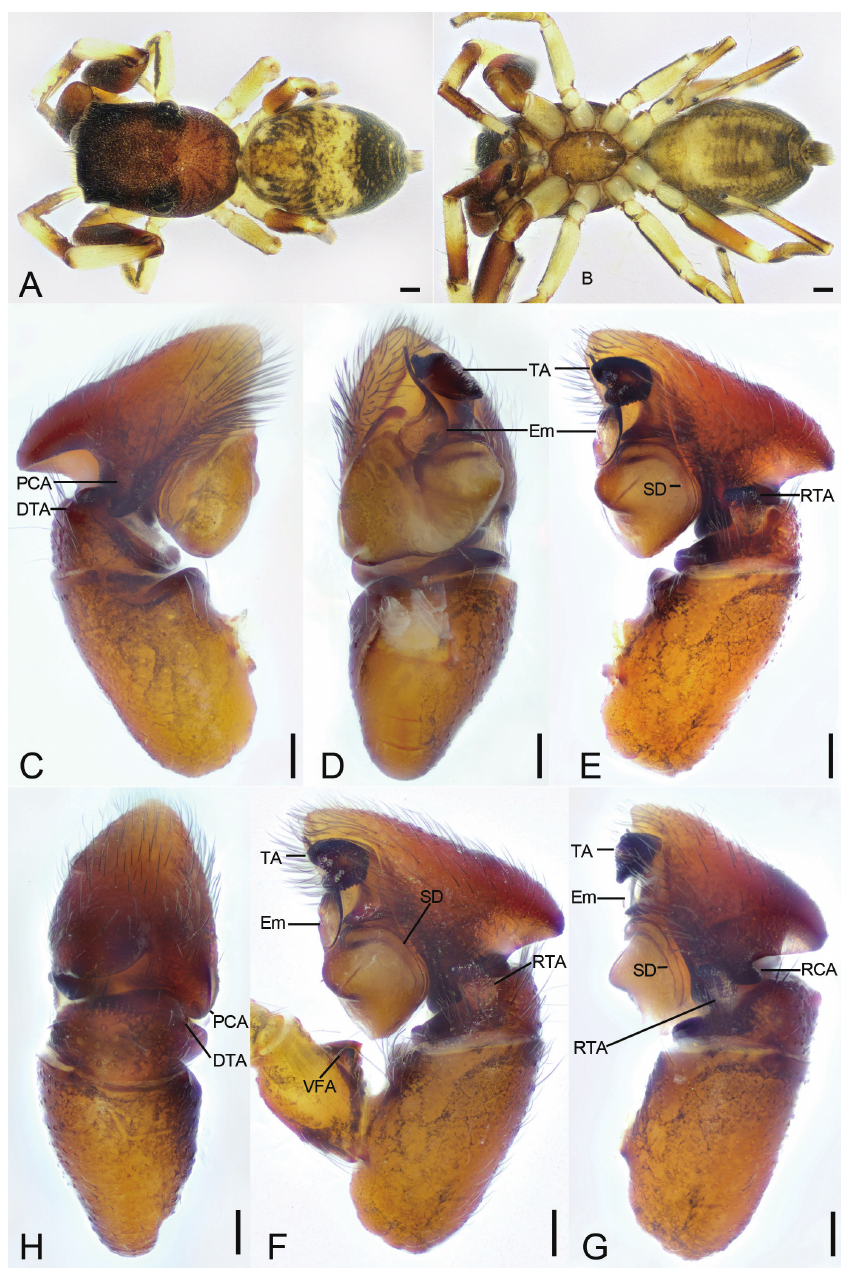
Figure 1. Synagelides emangou sp. nov., holotype male A habitus, dorsal view B same, ventral view C palp, prolateral view D same, ventral view E same, retrolateral view F same, detail of ventral femoral apophysis, retrolateral view G same, retrolateral view, slightly dorsal H same, dorsal view. Abbreviations: DTA – dorso- prolateral tibial apophysis, Em – embolus, PCA – postero-prolateral cymbial apophysis, RCA – postero-ret- rolateral cymbial apophysis, RTA – retrolateral tibial apophysis, SD – sperm duct, TA – terminal apophysis, VFA – ventral femoral apophysis. Scale bars: 0.2 mm ( A, B ); 0.05 mm ( C–E, G, H ); 0.1 mm ( F